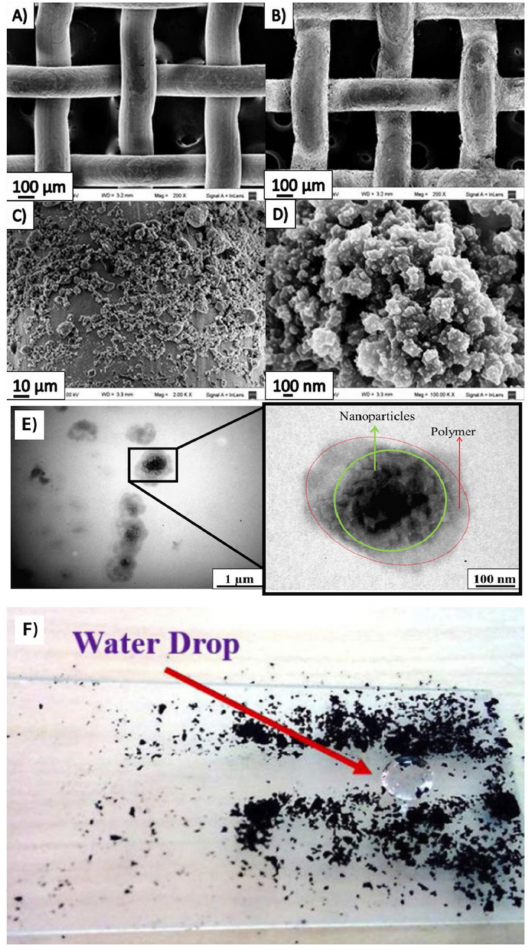
Figure 11. ( A , C ) Pristine brass mesh; ( B , D ) brass mesh coated with SiO 2 -PDMS-PVDF under different magnifications; ( E ) TEM images of the SiO 2 -PDMS-PVDF composite and a polymer coating around the SiO 2 nanoparticles (Reprinted from [32] with permission from Elsevier); and ( F ) self-cleaning property of a SH glass surface modified with silica nanoparticles (Reprinted from [50] with permission from